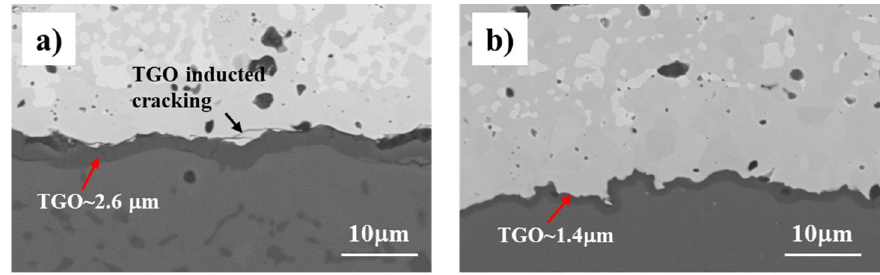
Figure 4. Coating microstructures after 900 FCT cycle tests in air. ( a ) APS EBCs; ( b ) LPPS EBCs.